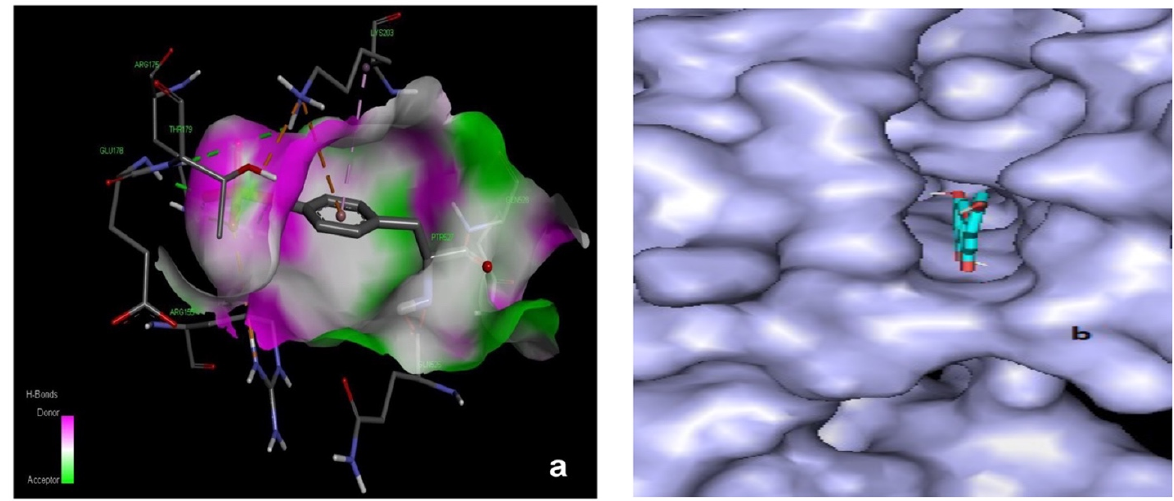
Figure 12. ( a , b ) : ( a ) Demonstrating Compound 6 in cavity of 5d6p ( b ) Compound 6 in the cavity of 2HCK. of